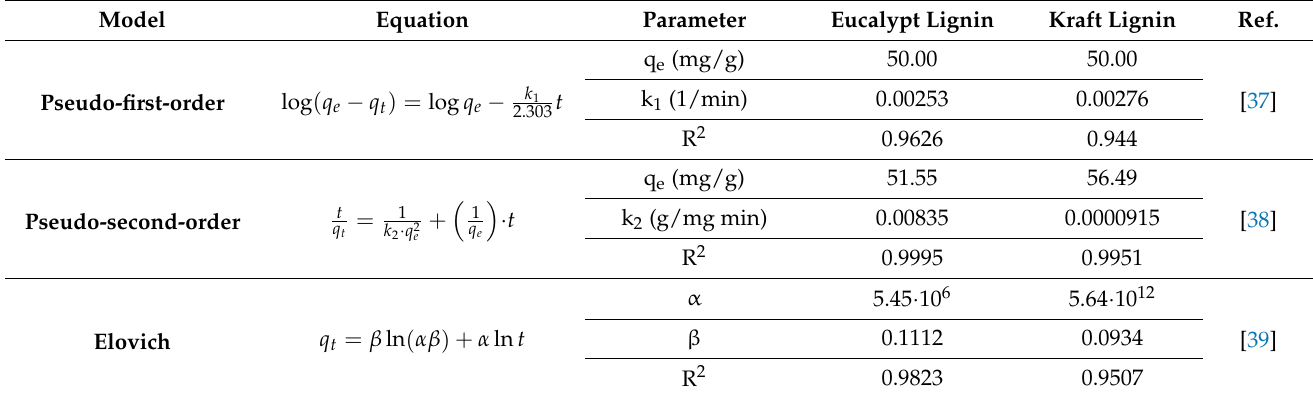
Table 3. Parameters of kinetic and diffusion models for Cr(VI) adsorption onto eucalypt stump and kraft